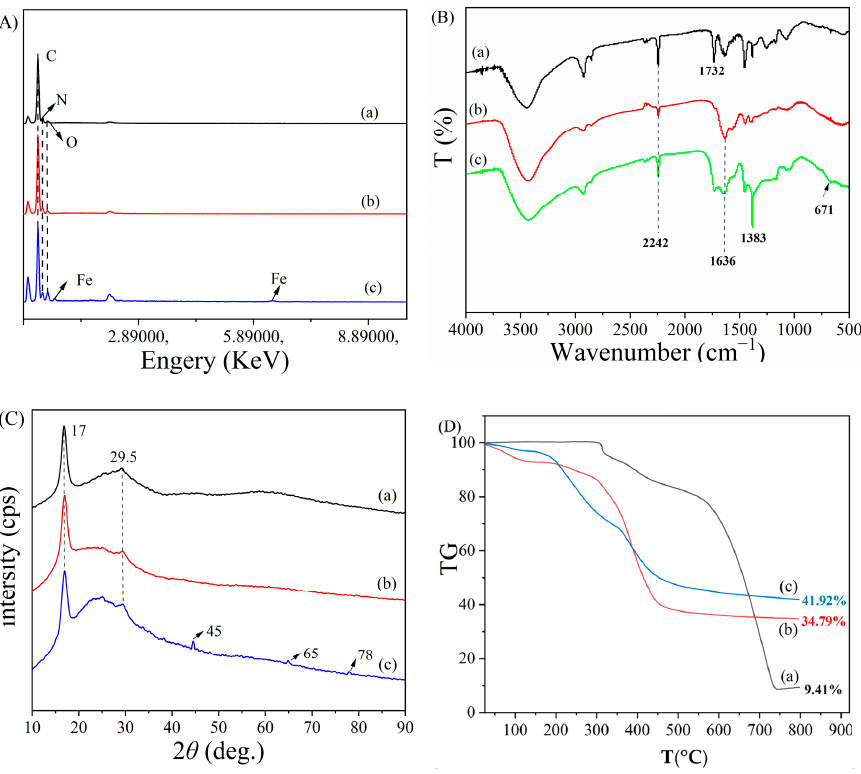
Figure 2. The SEM photographs of ( a ) PANF, ( b ) PAN A F, and ( c – f ) PAN A F-FeOOH prepared with Fe(OH) 3 colloid at 0.05, 0.2, 0.3, and 0.5 mol L − 1 , respectively. Magni fi cations are 200, 2000, and 20,000 times.